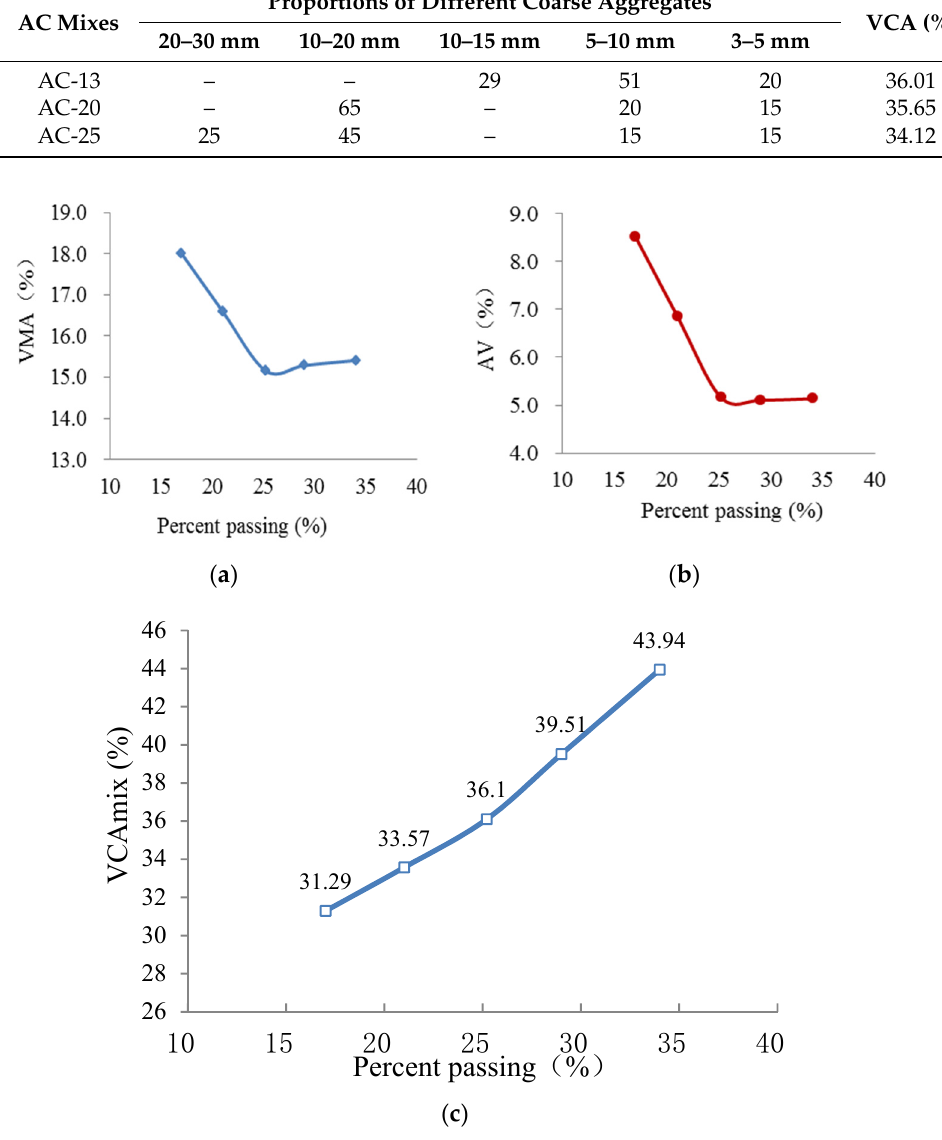
Figure 6. VPs of AC-13 samples versus PP. ( a ) VMA; ( b ) AV; ( c ) VCA mix .